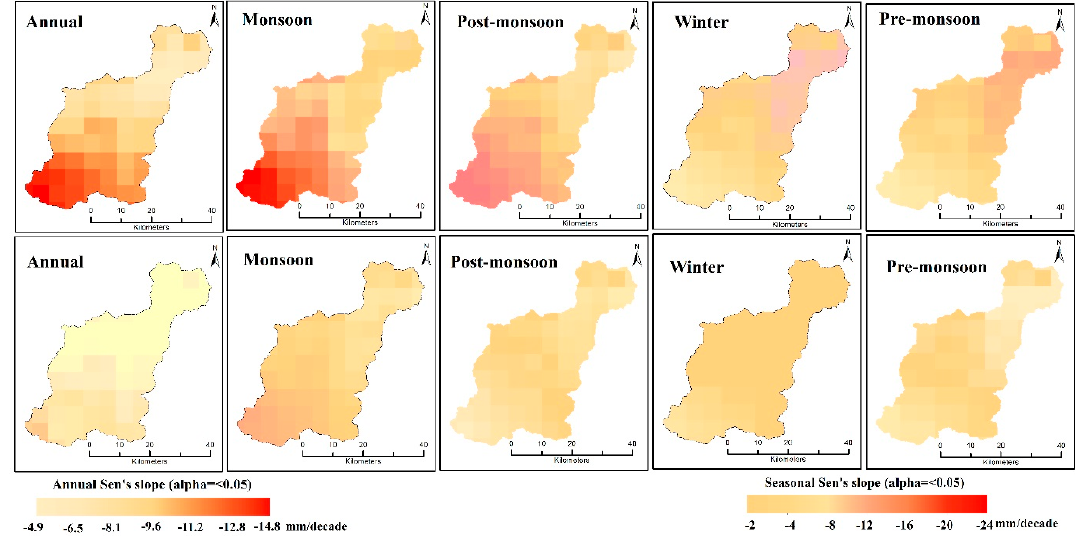
Figure 6. Spatial distribution of magnitude of trend in annual and seasonal rainfall, (Top panel showing a spatial tendency of CHIRPS and bottom panel PERSIANN-CDR data respectively).